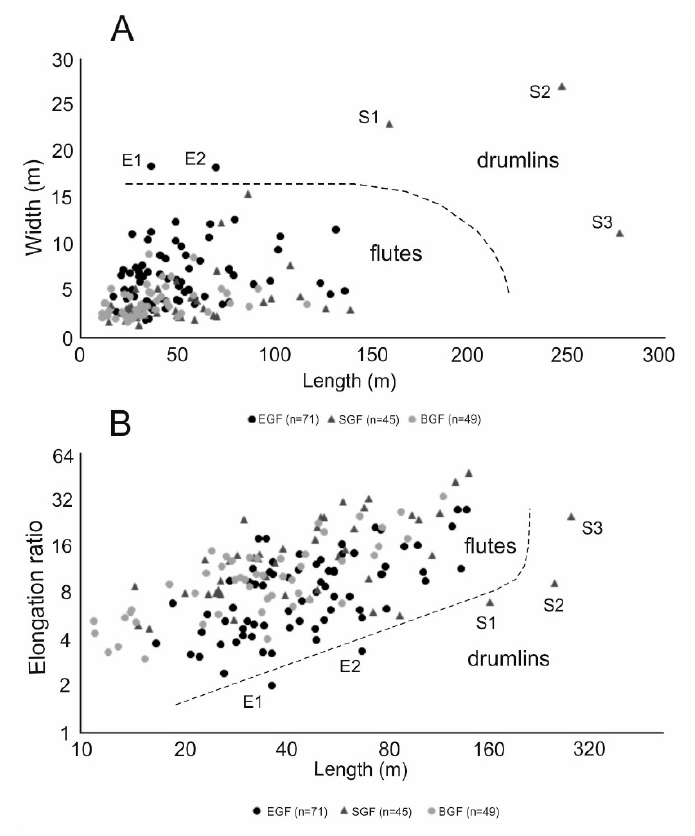
Figure 11. Length-to-width ( A ) and length-to-elongation ratio ( B ) diagrams for 165 analyzed flutings and drumlins (note that the axis scales of the diagram B are logarithmic); drumlins are marked E1 and E2 (Ecology Glacier foreland) and S1-S3 (Sphinx Glacier foreland).